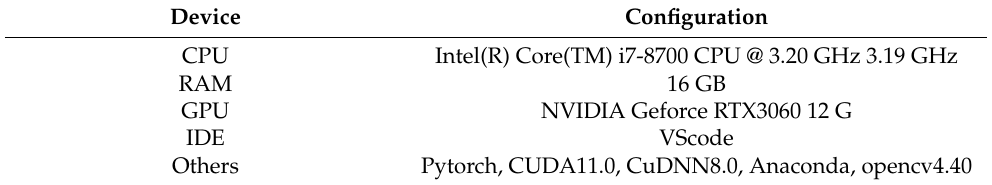
Table 5. Experimental device configuration.